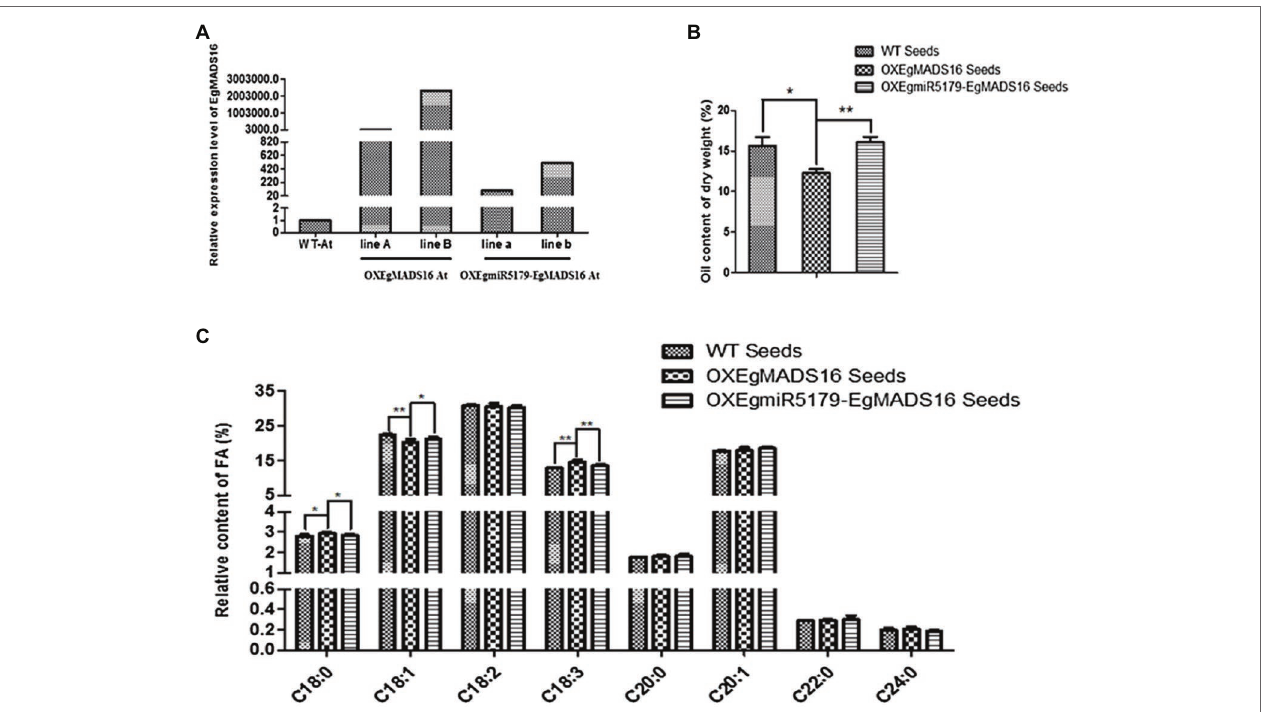
FIGURE 6 | The effect of EgMADS16 on lipid biosynthesis is inhibited by EgmiR5179 in Arabidopsis. (A) The relative expression level of EgMADS16 in wild-type and transgenic Arabidopsis. (B) The oil content of wild-type and transgenic Arabidopsis seeds. (C) The relative FA content of wild-type and transgenic Arabidopsis seeds. The values are the means ± SD ( n = 3), “*” represents a significant difference ( p < 0.05), and “**” represents a highly significant difference ( p < 0.01) using Student’s t -test. OXEgmiR5179-EgMADS16 At: Arabidopsis coexpressed EgmiR5179 and EgMADS16 .